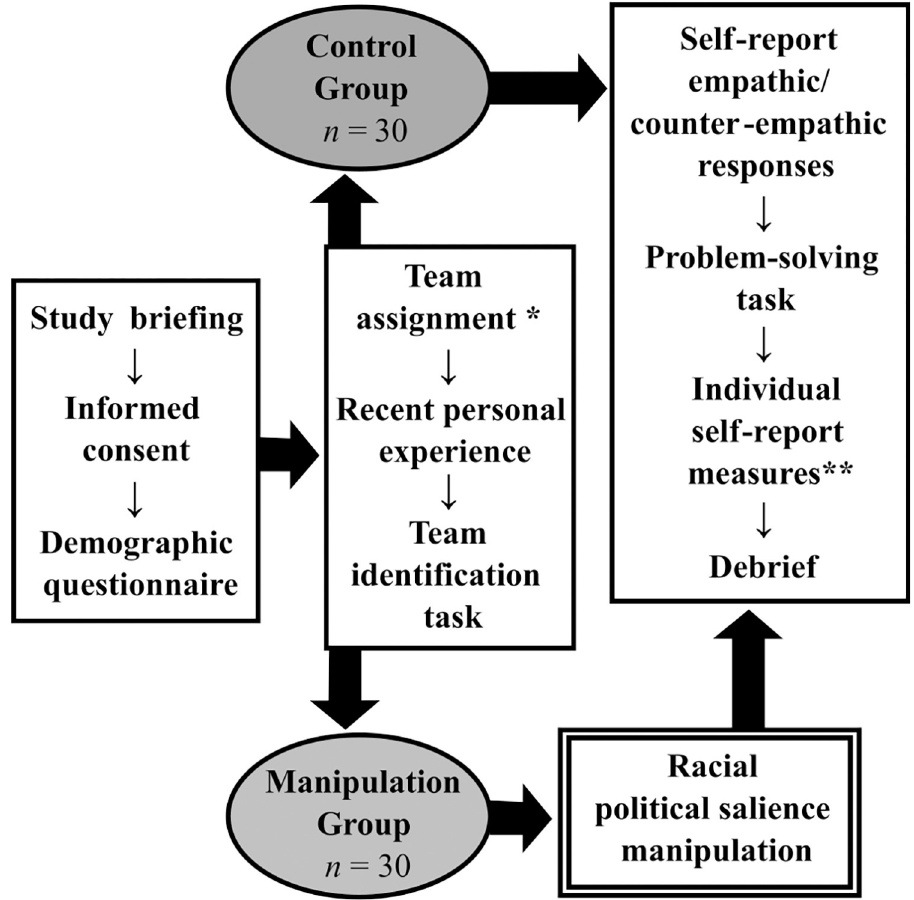
Fig 1. Flow diagram detailing the data collection procedure. * All participants were assigned to the Eagles team. ** These included the (i) Internal and External Motivation to Respond Without Prejudice scales (IMS/EMS) [83]), and (ii) perceptions of Black African and White historical